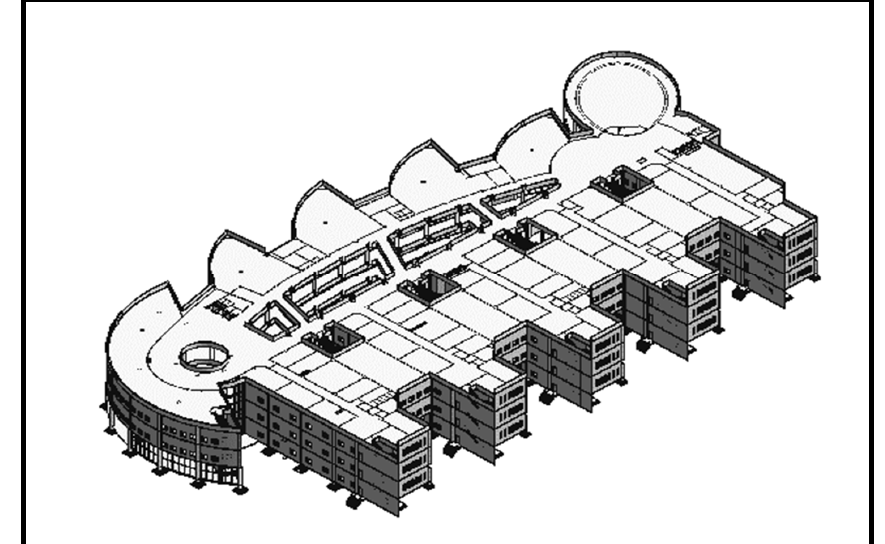
Fig. 10. Building information model for the case study